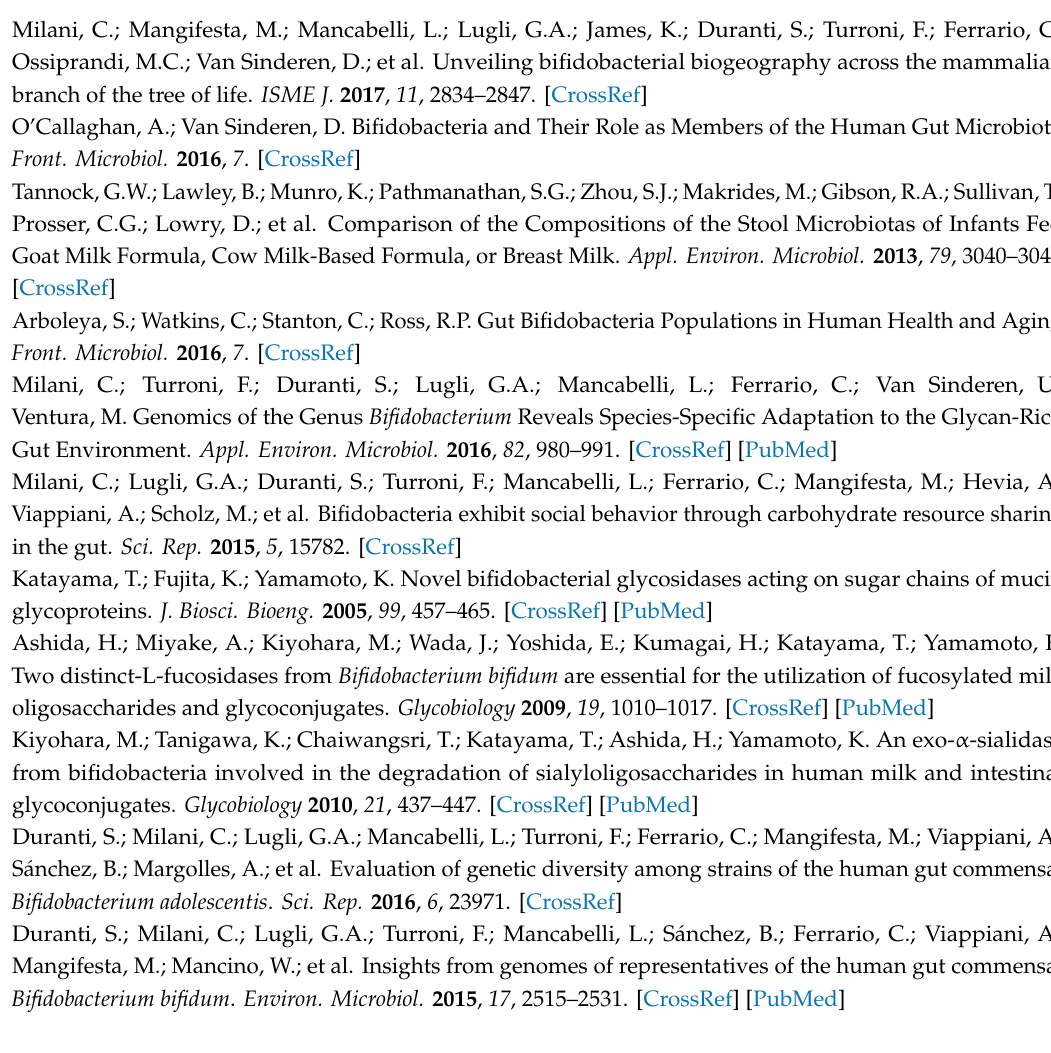
Figure S1. LGI and WAS models. Figure S2. Dotplot alignments of fully sequenced B. bifidum